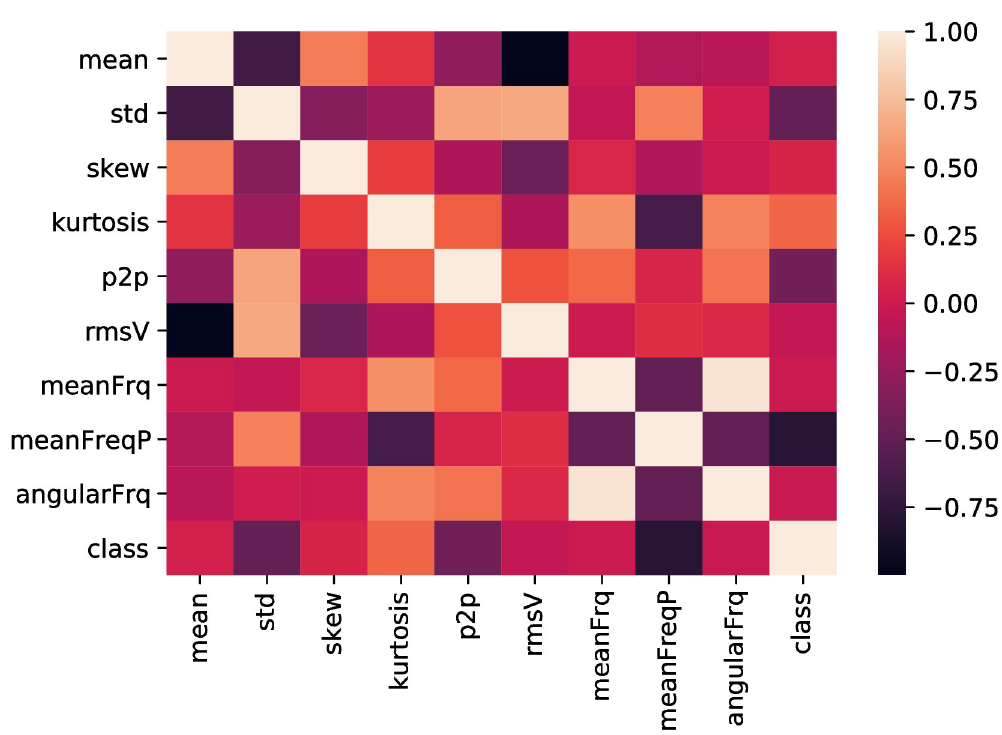
Fig 12. Feature heatmap of utilized AE